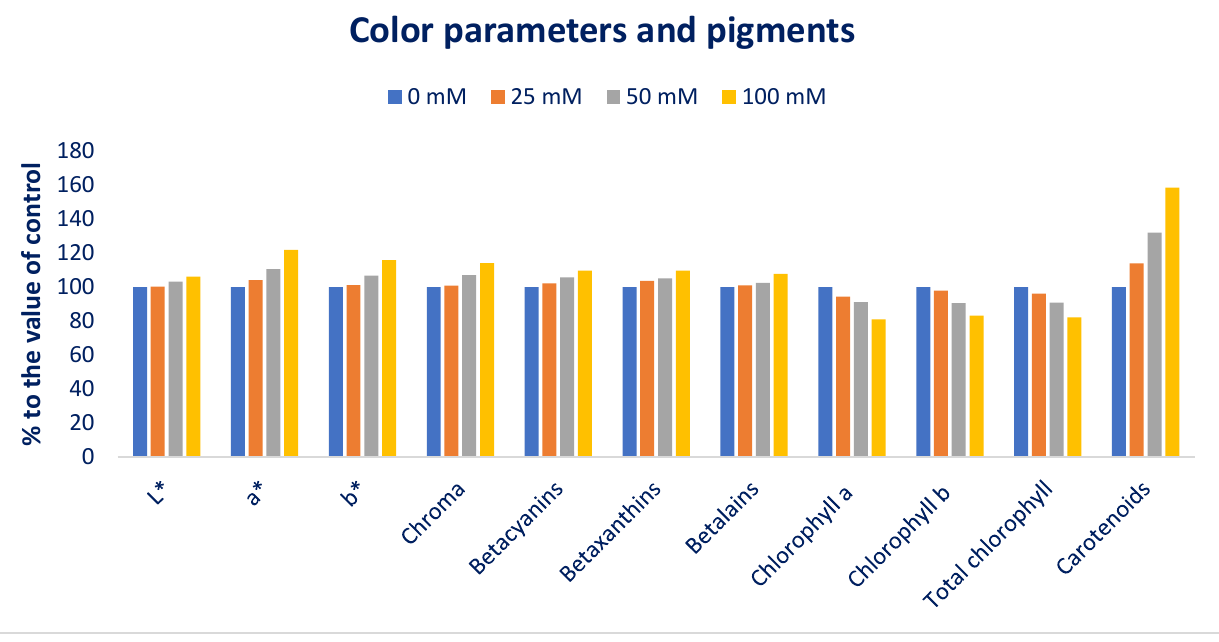
Figure 3. The salt-induced increment in color attributes and pigments (%) over control in Lalshak. Sodium chloride stress affected plant growth and development through decreasing stomatal conductivity, which restricts CO 2 influx to leaves and causes osmotic stress in plants, reduction in water potential, and unfavorable CO 2 /O 2 ratios in chloroplasts, reduc- ing photosynthesis. Lim et al. [53] reported that different salt concentrations augmented carotenoid content. They observed the highest increment (two-fold) in carotenoids under 50 and 100 mM salt concentrations in comparison to the control conditions. Alam et al. [54] observed both stimulation and reduction in carotenoid content in salt-stressed purs- lane. To regulate plant development under sodium chloride stress, the plant accelerates the mevalonic acid pathway for the biogenesis of abscisic acid from carotenoids. Thus,